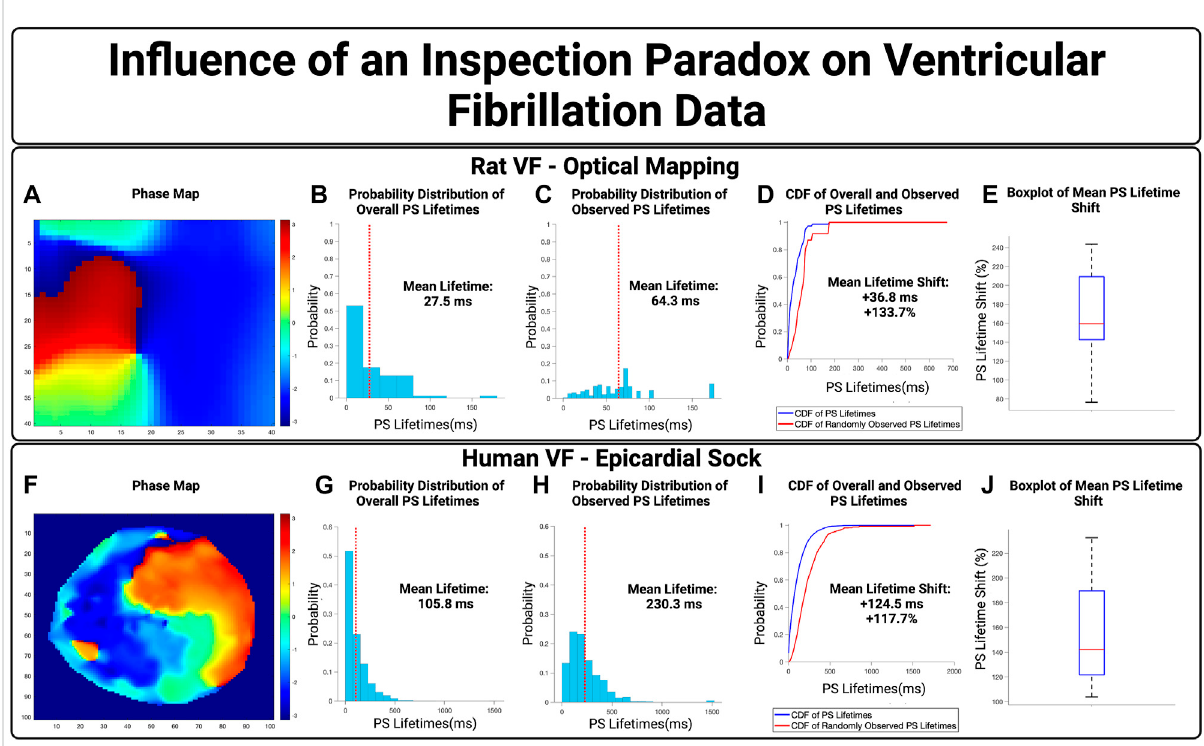
FIGURE 5 TheIn fl uenceofaninspectionparadoxonVFdata. (A – D) ShowanexamplecaseofopticallymappedratVF,and (F – I) showsanexamplecaseof human VF recording through a 256 electrode epicardial sock. (B,G) Show the overall distribution of PS lifetimes across full epochs of VF. (C,H) Show the distribution of PS lifetimes observed across the 10,000 samples. (D,I) Presents the cumulative distribution functions (CDF) of the overall and observed PS lifetimes. (E) In opticallymappedratVF,there wasan increase in themean PS lifetime of+40.0 ms(95% CI,±5.1 ms)and an overall meanlifetime shiftof+171.3%(95%CI,± 15.6%)( p < 0.001 forobservedvs.overall). (J) InhumanVF,inn=8cases,there wasan increase inthemean PS lifetime of +159.5 ms (95% CI, ±15.2 ms) and an overall mean lifetime shift of +153.5% (95% CI, ± 15.7%) ( p < 0.001 for observed vs.